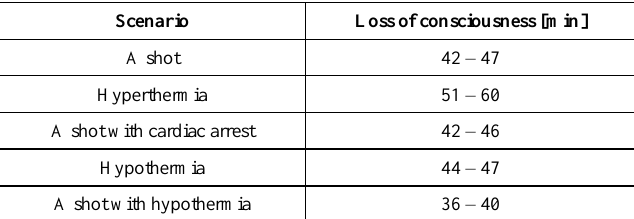
Table 1. Estimated time of losing consciousness by